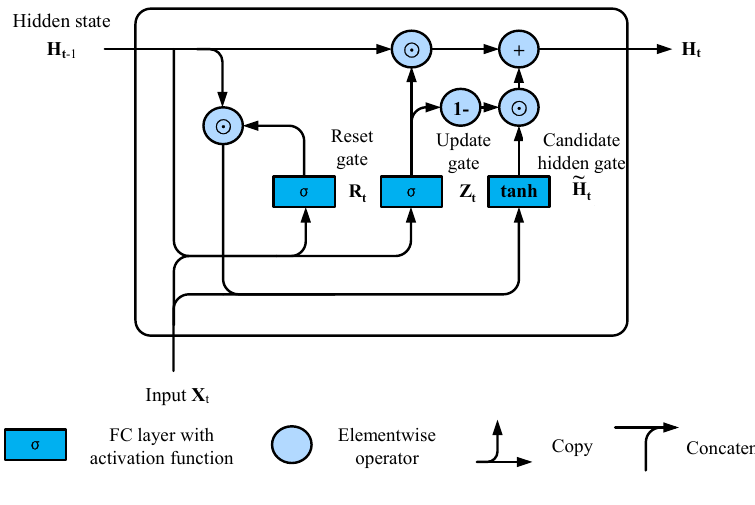
Figure 9. GRU computational flow